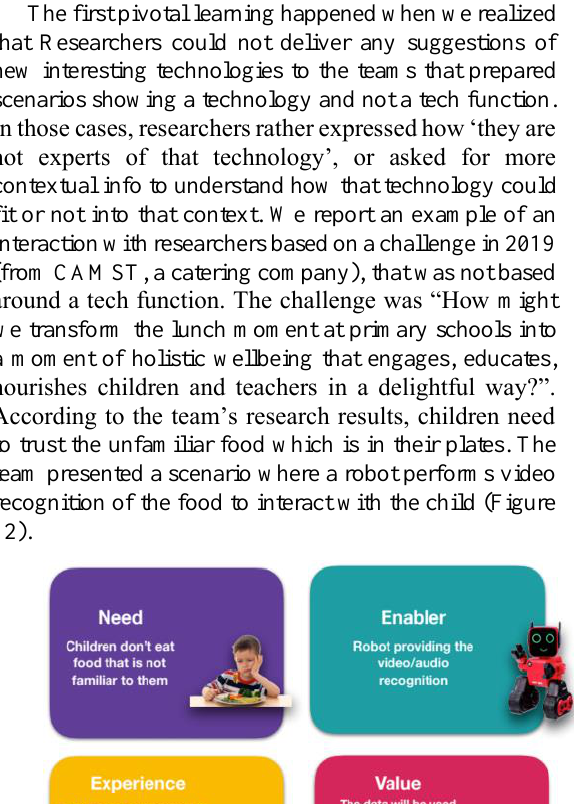
Fig. 13. When (in which phases) the team should use the N2T